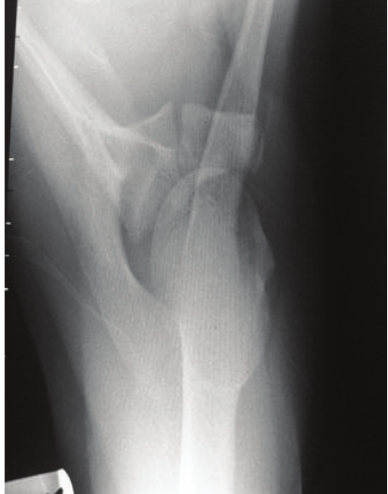
Figure 4: Case B: initial axillary radiograph.